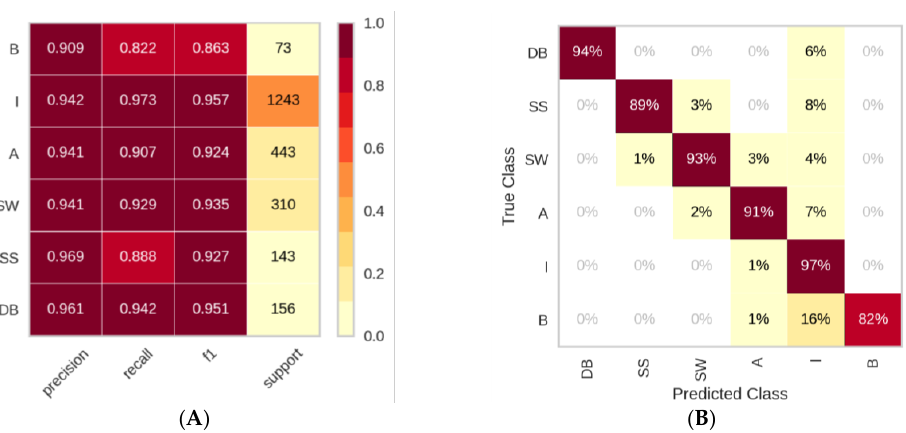
Figure 11. Classification report ( A ) and the confusion matrix ( B ) resulting from the best classification model XGBoost for six-class classification.